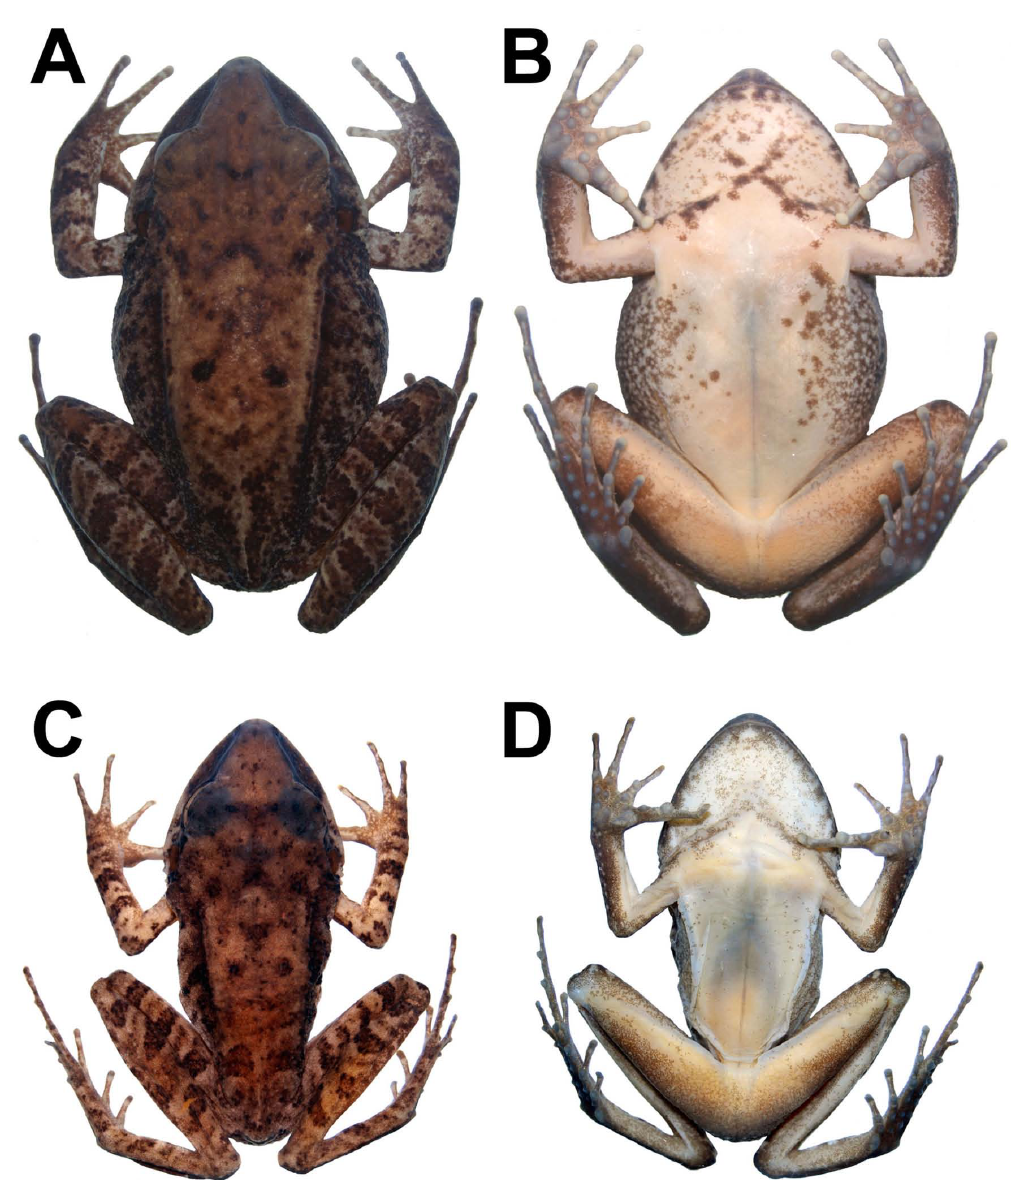
Figure 4. Strabomantis